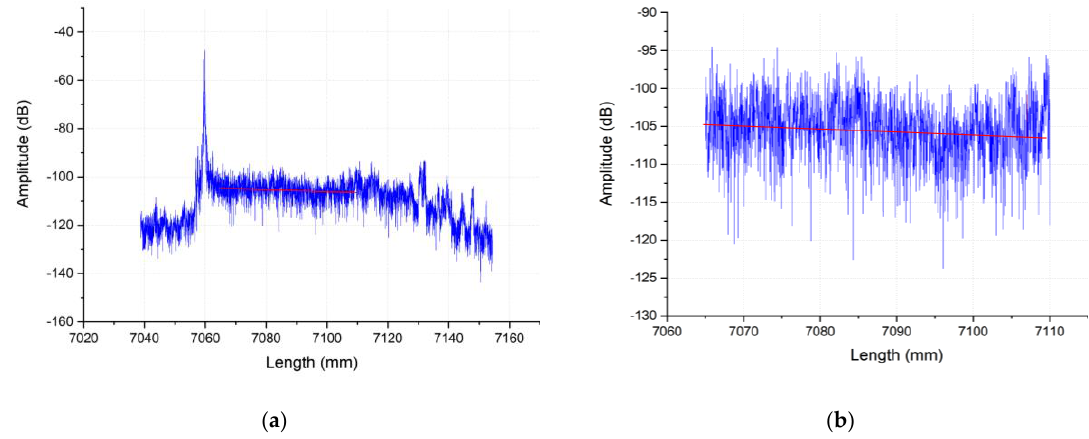
Figure 4. Waveguide reflectogram with a width of 8 microns and a length of 60 mm: general view ( a ); section with linear extrapolation ( b ). Table 2. Optical losses for waveguide structures with widths of 3 and 8 microns and a length of 60 mm. Waveguide Structure Width, µ